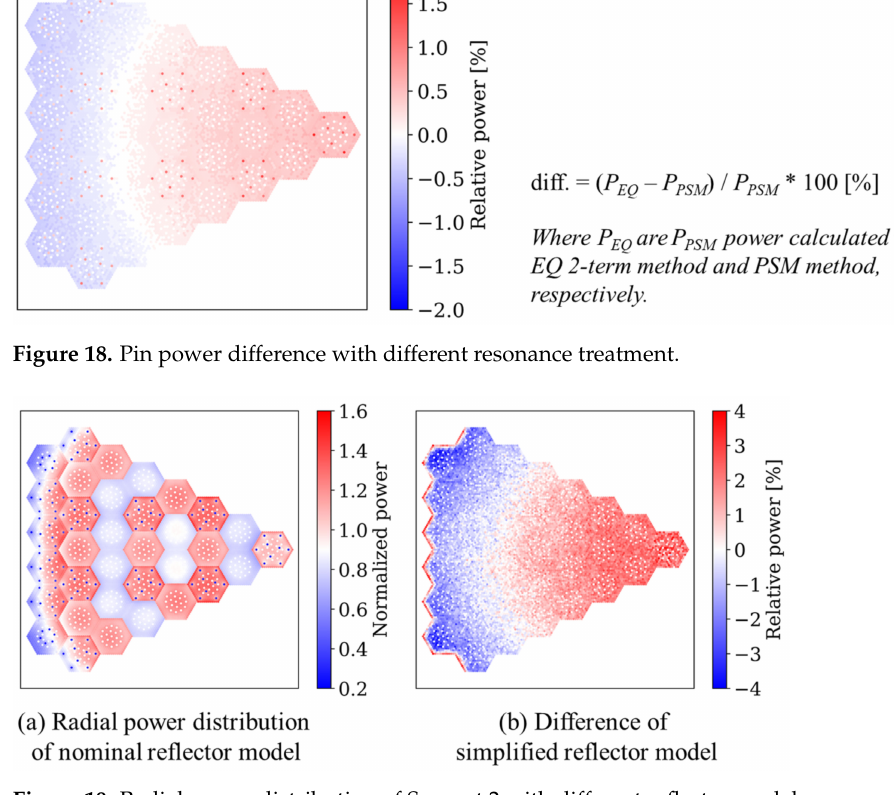
Figure 19. Radial power distribution of Serpent 2 with different reflector models. Table 4. Multiplication factor of three difference test cases.